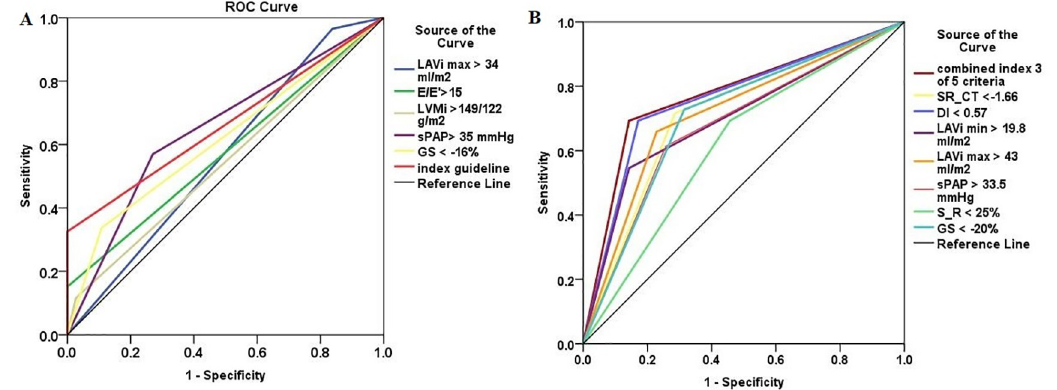
Fig 4. Comparative receiver-operating curves of guideline and new echocardiographic parameters for HFpEF diagnosis. The new echocardiographic parameters ( Panel B ) showed higher AUC compared to all current guideline parameters ( Panel A ). A combined index of 3 from 5 parameters with the highest AUC (SR_CT, sPAP, GS, DI, LAVi min) identified HFpEF better than the actual guideline index and all parameters alone, including the new ones. LAVi, left atrium volume indexed; E/E’, ratio between early diastolic mitral inflow to mitral annular early diastolic tissue velocities; LVMi, left ventricle mass indexed; sPAP, systolic pulmonary arterial pressure; GS, global strain; SR_CT, LA contractile strain rate; DI, distensibility index; S_R, LA reservoir strain.